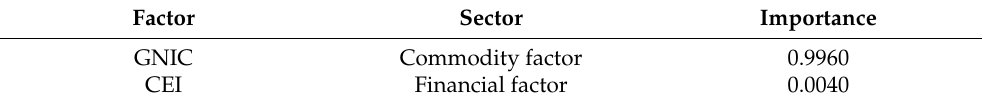
Table 8. Description of the most important selected factors, using random forest. Factor